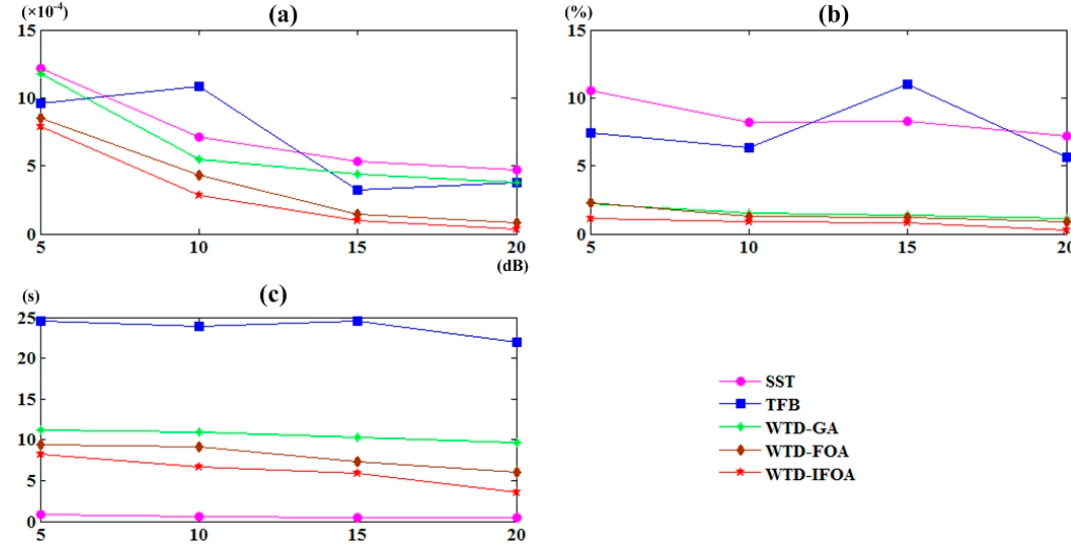
Figure 9. Comprehensive comparison of the five methods: ( a ) Mean square error of the five methods; ( b ) Peak value error of the five methods; and ( c ) Computation time of the five methods.